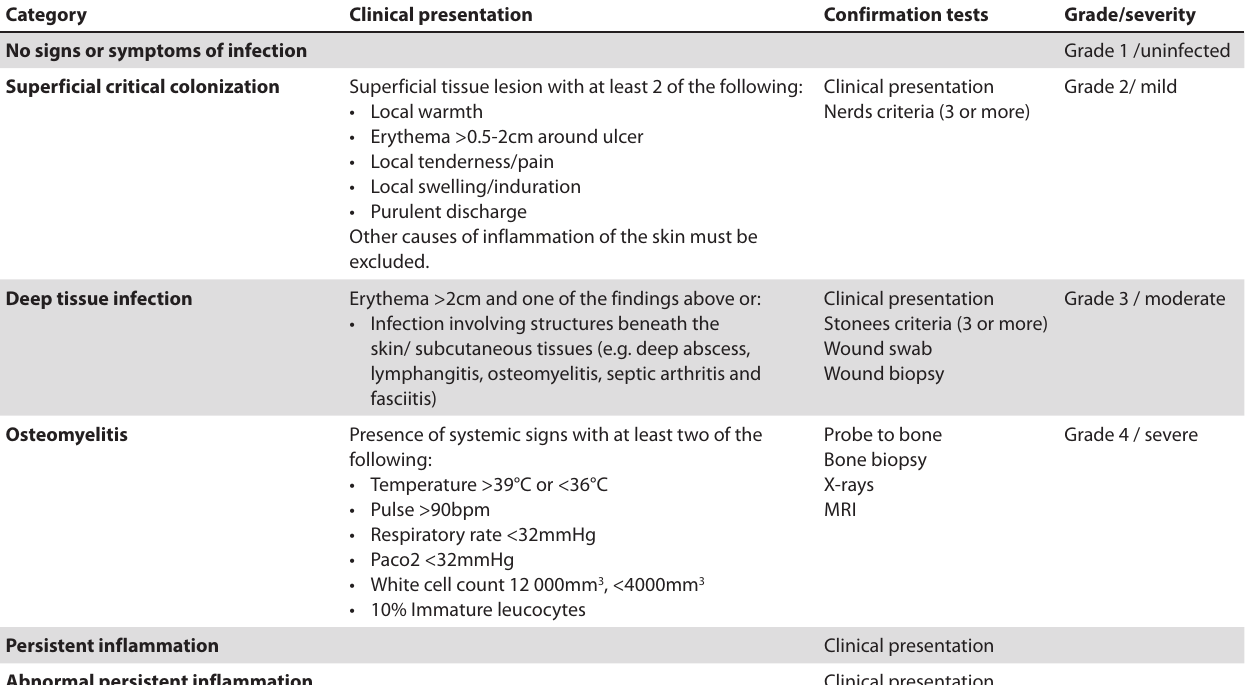
Table 10: Classification and severity of diabetic foot infections 3,5,12